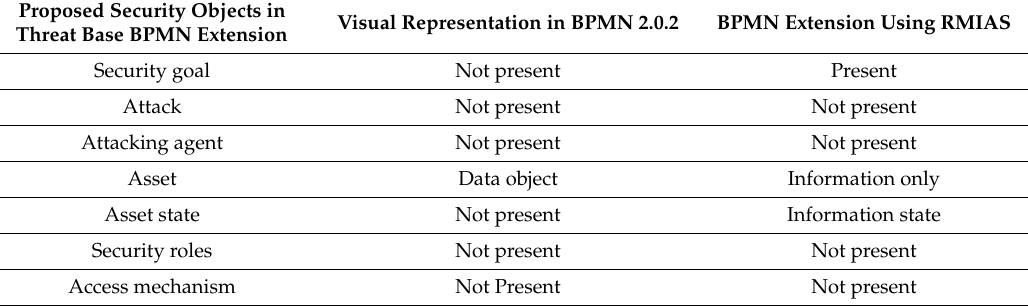
Table 7. Comparison of proposed BPMN security objects with BPMN 2.0.2 and Reference Model of Information Assurance (RMIAS)